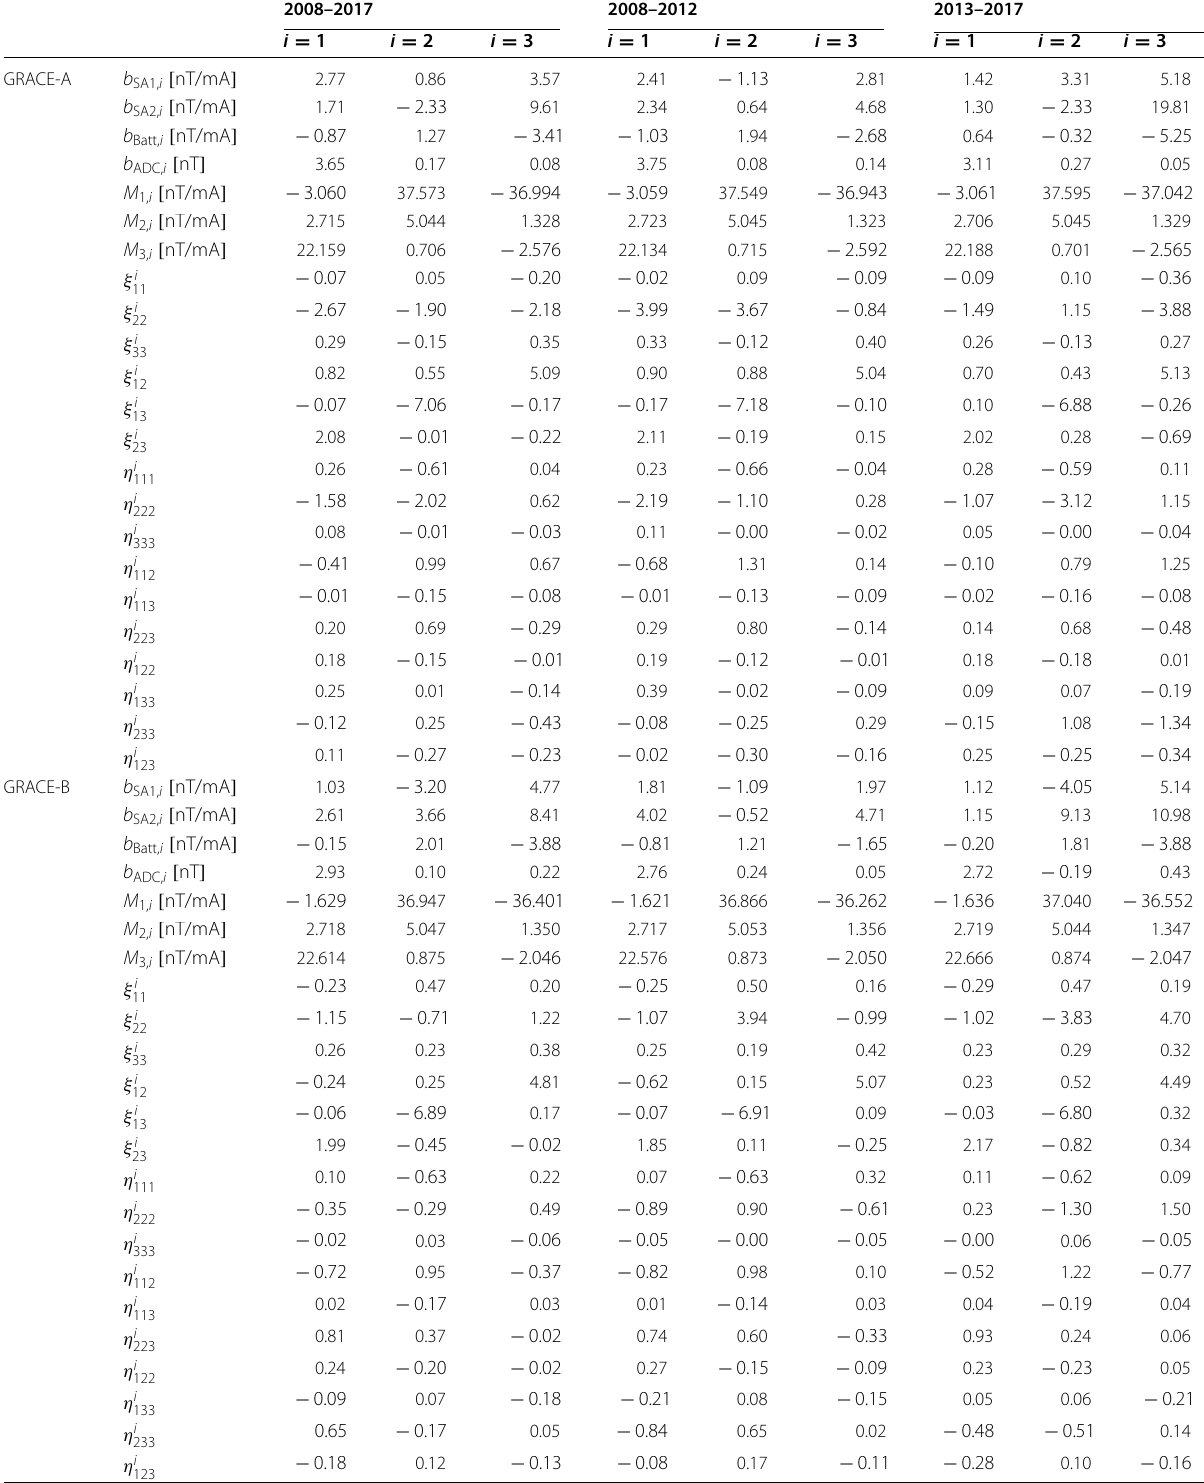
Table 2 List of some common calibration